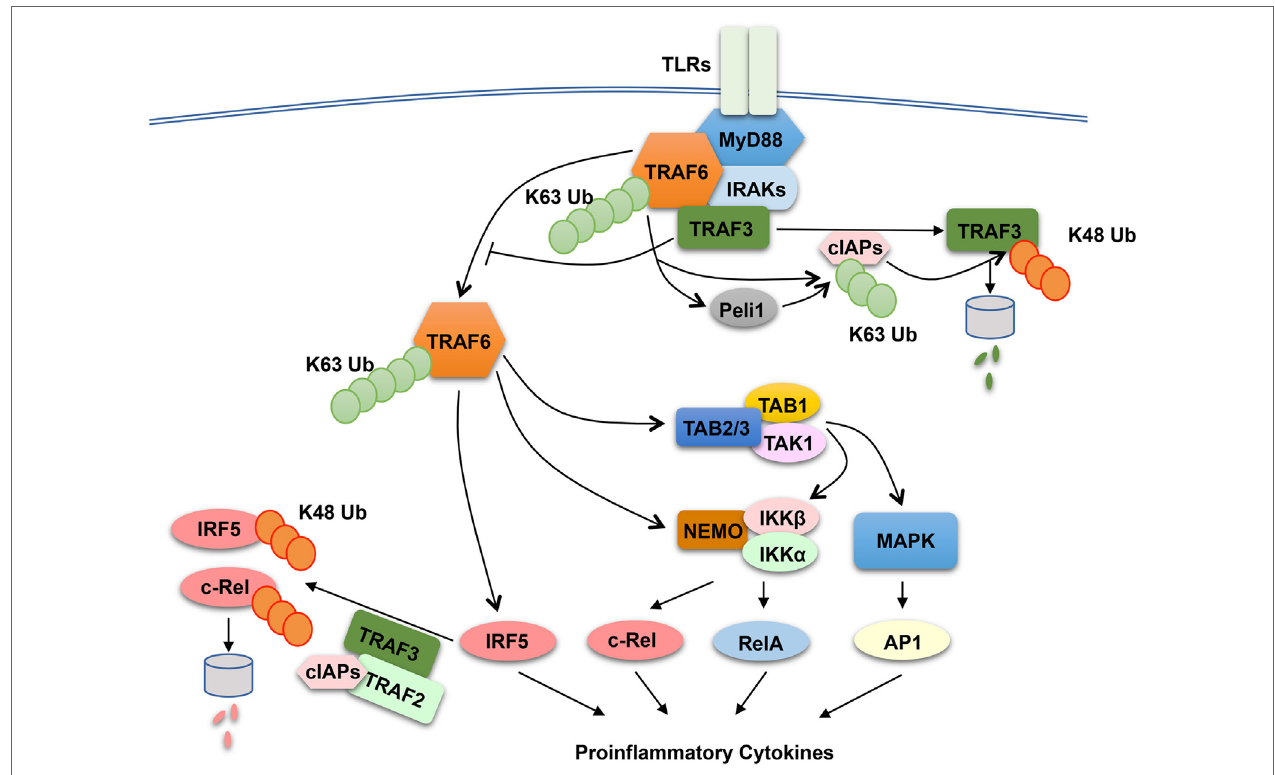
FigURe 3 | Anti-inflammatory function of tumor necrosis factor receptor-associated factor (TRAF)2 and TRAF3 in toll-like receptor (TLR) signaling pathway. In responds to TLR stimulation, TRAF6 is recruited to the MyD88 signaling complex. Upon activation, the TRAF6 complex relocates from the plasma membrane to the cytoplasm, a signaling step required for activation of the downstream nuclear factor κ B and mitogen-activated protein kinase (MAPK) pathways. TRAF3 negatively regulates TLR-stimulated proinflammatory cytokine induction via two potential mechanisms. The first is to target the MyD88–TRAF6 complex and prevents the relocation of TRAF6 to the cytoplasm, and the second is to function together TRAF2 and cIAPs to mediate ubiquitin-dependent degradation of two major proinflammatory transcription factors, c-Rel and interferon regulatory factor 5 (IRF5). TLR signaling temporarily overrides the negative signaling function of TRAF3 by inducing TRAF3 proteolysis. In this process, TRAF6 activates cIAPs (cIAP1 and cIAP2) through K63 ubiquitination, which in turn function as E3 ubiquitin ligases to mediate K48-linked ubiquitination and proteolysis of TRAF3. In microglia, Peli1 appears to cooperate with TRAF6 or function downstream of TRAF6 to mediate cIAP